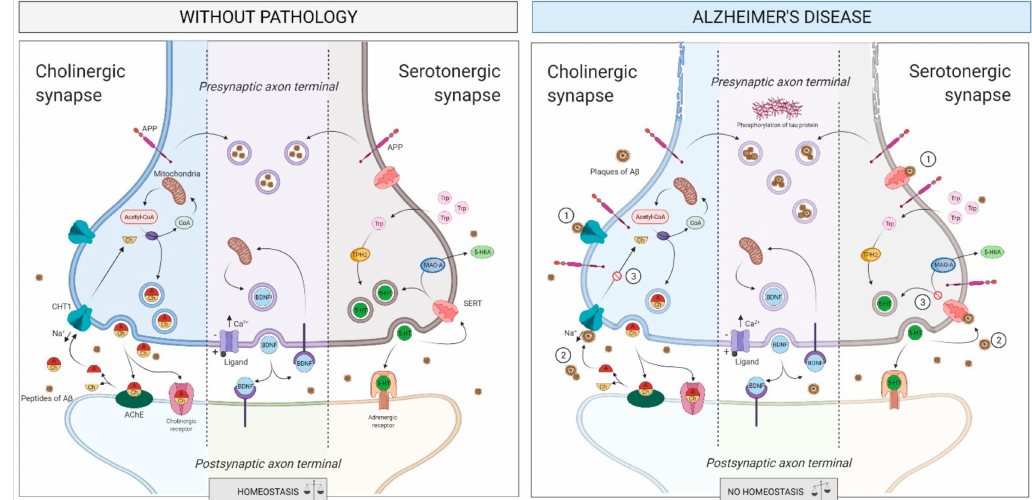
Figure 5. Intercellular communication within nervous system pathway. In AD, the accumulation of A β in the surface receptors (step 1) and the synaptic spaces (step 2) causes a reduction in neurotransmitter levels, impeding the recapture of these (step 3) and increasing the phosphorylation of tau protein and the creation of A β plaques inside the axon. Abbreviations: 5-HIIA, 5-hydroxy indoleacetic acid; 5-HT, 5-hydroxytryptamine or serotonin; A β , amyloid beta; Acetyl-CoA, acetyl coenzyme-A; Ach, acetylcholine; AChE, acetylcholinesterase; APP, amyloid protein precursor; BDNF, brain-derived neurotrophic factor; Ca 2+ , calcium ion; CHT1, high-affinity choline transporter 1; CoA, coenzyme-A; MAO-A, monoamine oxidase A; Na + , sodium ion; TPH2, tryptophan hydroxylase 2; Trp, tryptophan; SERT, serotonin